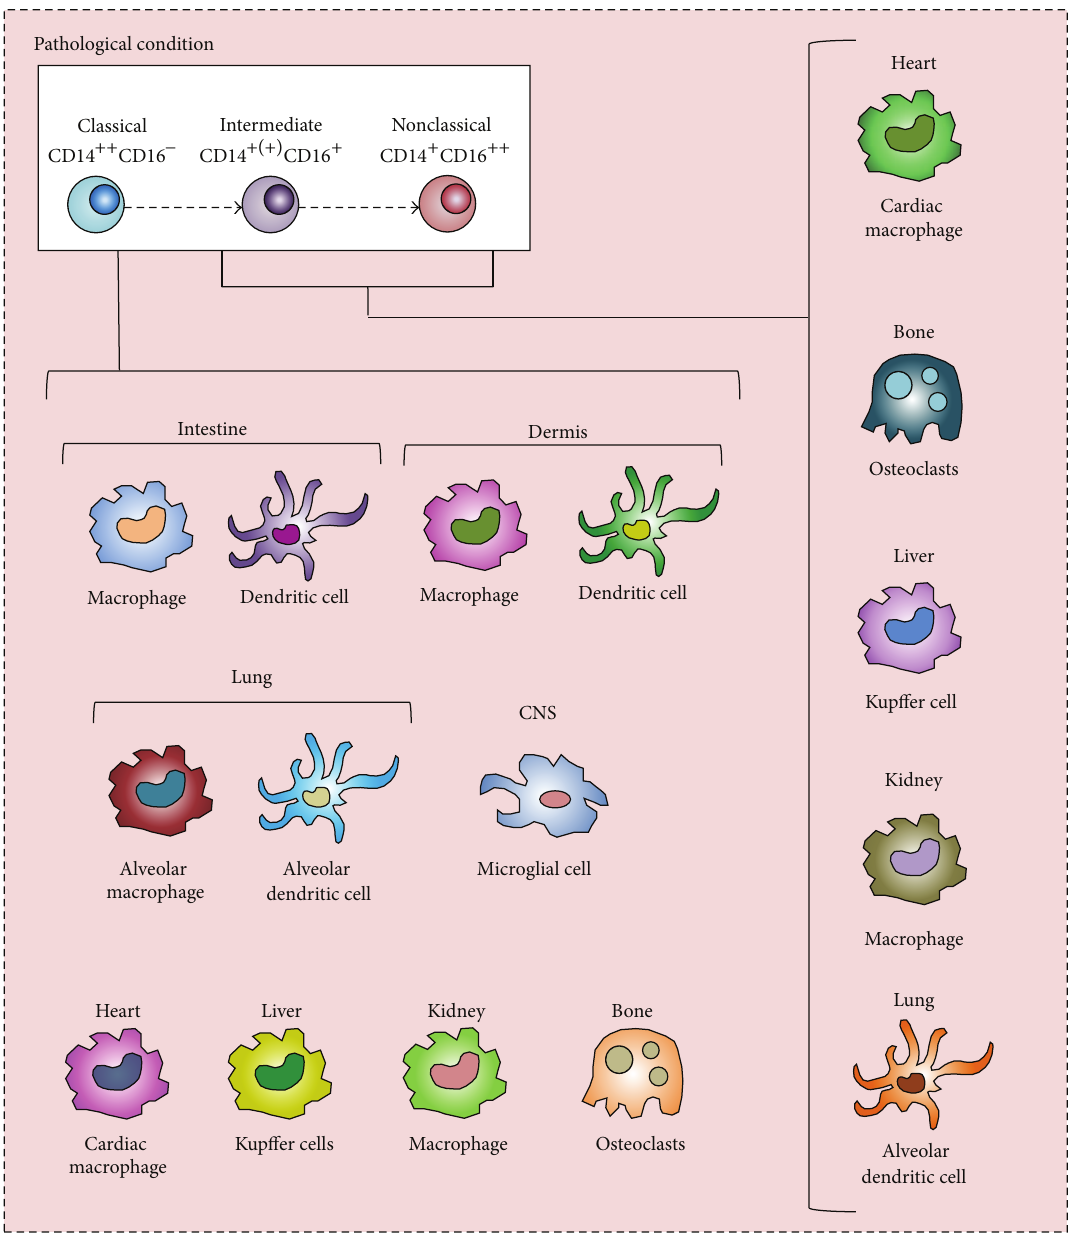
Figure 2: Proposed increased recruitment and differentiation of monocytes during inflammation. The contribution of monocytes to populations of mature immune cells is dramatically increased in various inflammatory conditions. Populations of immune cells normally not maintained by monocyte influx, such as populations of DCs and macrophages in the lungs, CSN, heart, liver, and kidney, are being provided by monocyte-derived counterparts during inflammation. Intermediate and nonclassical monocytes differentiate into immune cells with features distinctly different from the ones generated from classical monocytes during